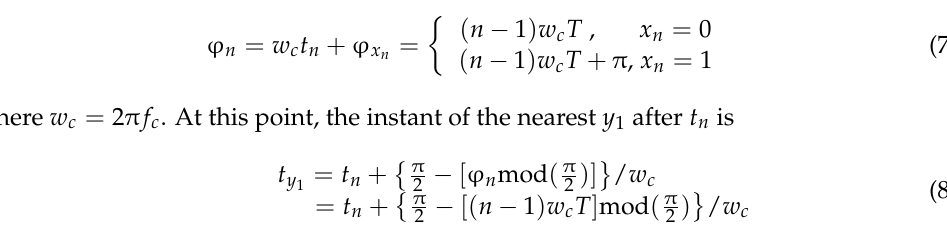
, , y y y ) in CB-Gardner. Figure 4. The positions of three detection points ( y 1 , y 2 , y 3 ) in 1 2 3